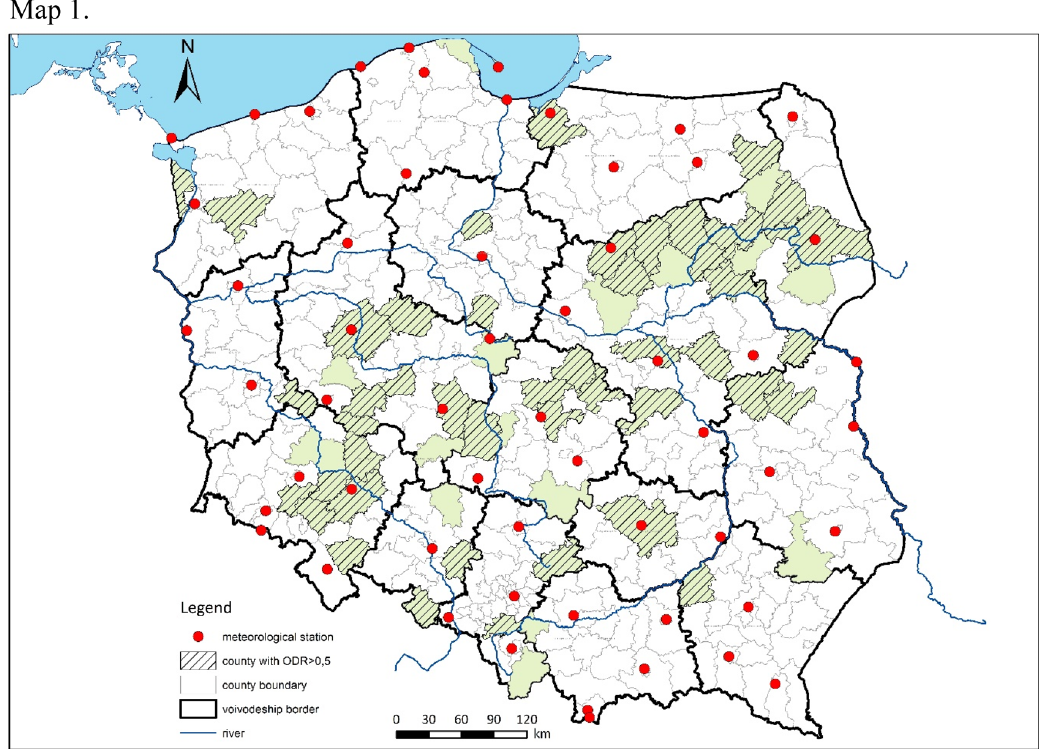
Figure 9. Locations in Poland of sample collection (green areas) and weather stations from which data were obtained (red dots). Hatching indicates districts with ODR values ≥ 0.5 during the period